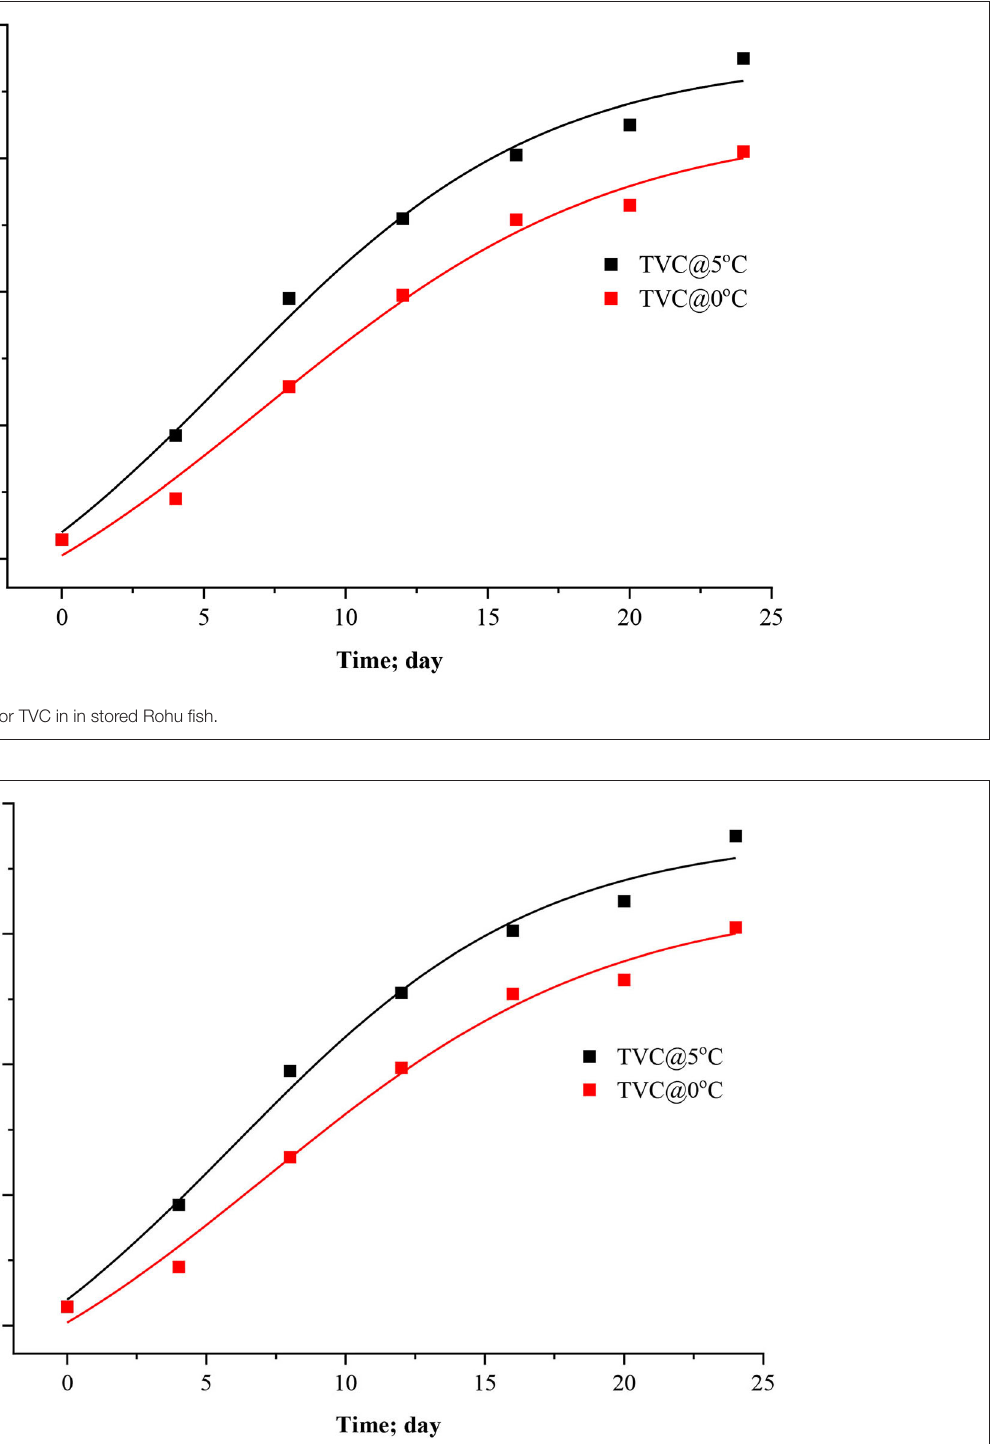
FIGURE 6 | Modified logistic model curve for TVC in stored Rohu